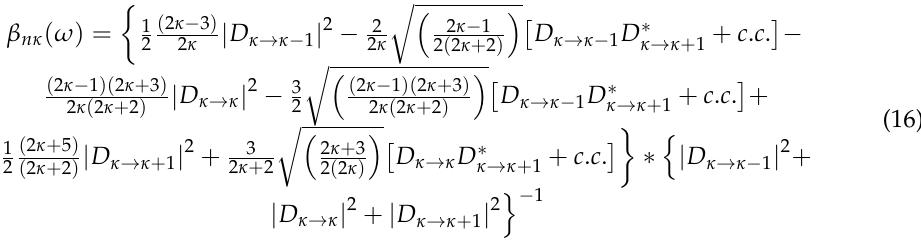
Photon energy (a. u.) Figure 4. Angular distribution asymmetry parameter (β) of 2p 3/ 2 (Left), 2p 1/2 (Middle), and 2s (Right) subshells of Ne (black) and Ne@XFEL (red). Solid, dashed, and dotted vertical lines repre- sent the threshold for 2p 3/2 , 2p 1/2 , and 2s thresholds of free (black) and confined atom (red), respec- tively.